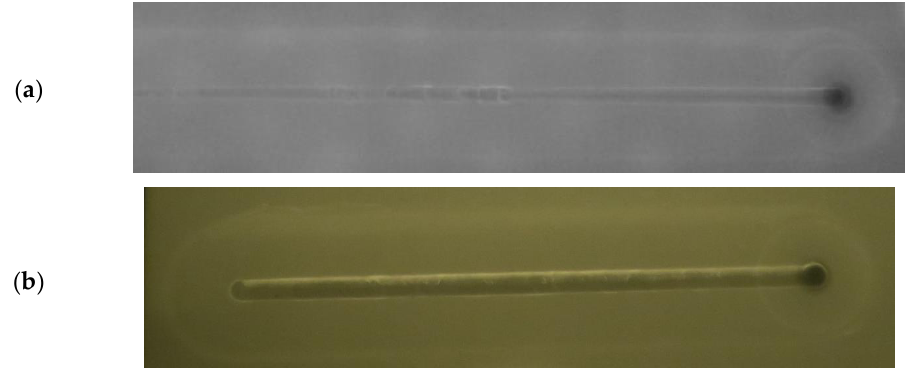
Figure 8. X-ray test for samples 953 ( a ) and 996 ( b ).